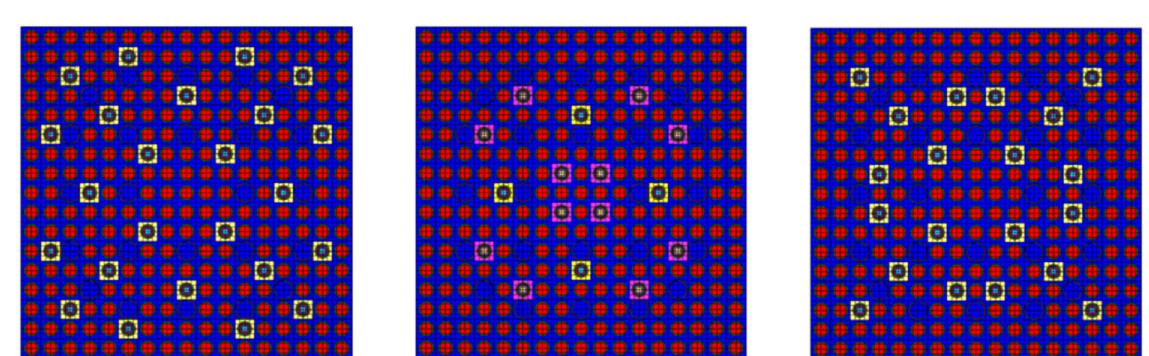
Fig. 2. U.K. EPR FA, enr. 5.0% @ 24 Gd fuel pins (left); U.S. EPR FA, enr. 3.25% @ 16 Gd fuel pins (center); U.K. EPR FA, enr.